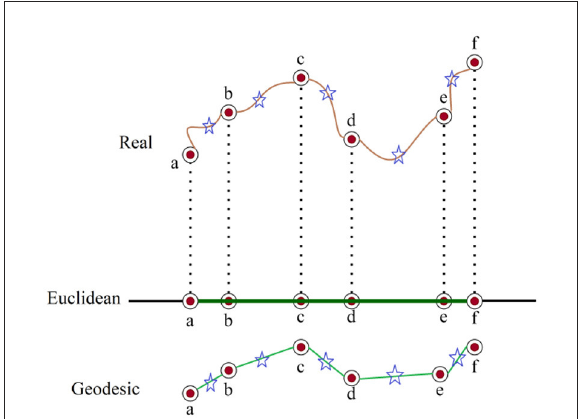
FIGURE4 The mechanism of Isomap.